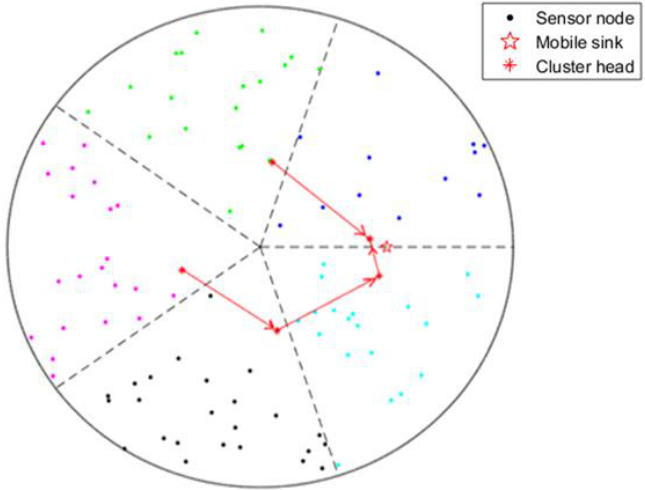
Figure 5. Chain of CHs generation.